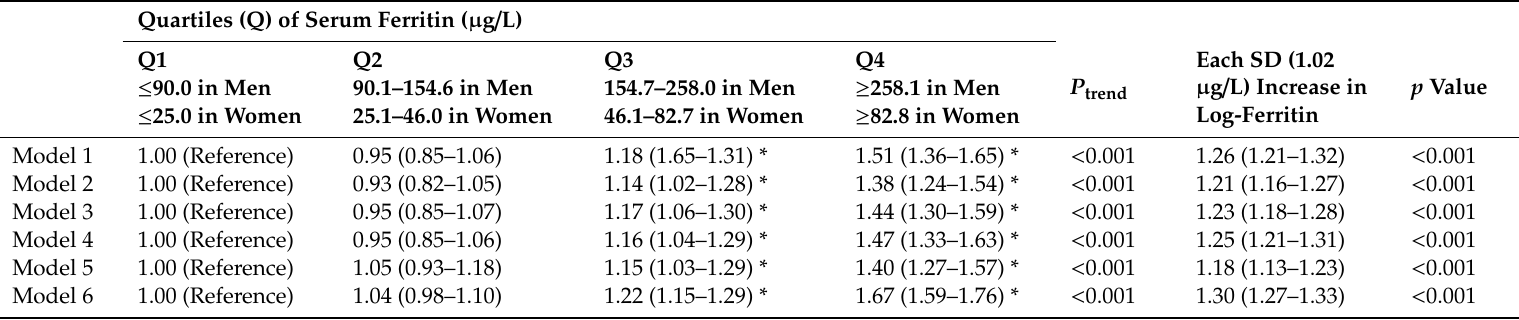
Table 4. Sensitivity analyses. Multivariable-adjusted HRs (95% CIs) for incident type 2 diabetes according to sex-specific quartiles of serum ferritin in various